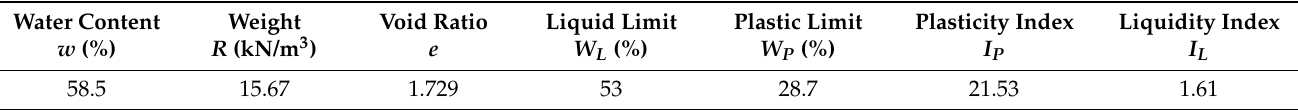
Table 1. Basic Physical and Mechanical Indicators of Silt.